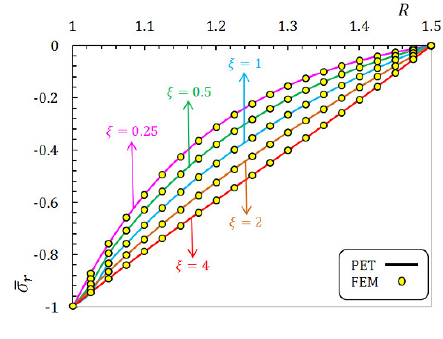
Figure 4. Radial distribution of radial stress ( η